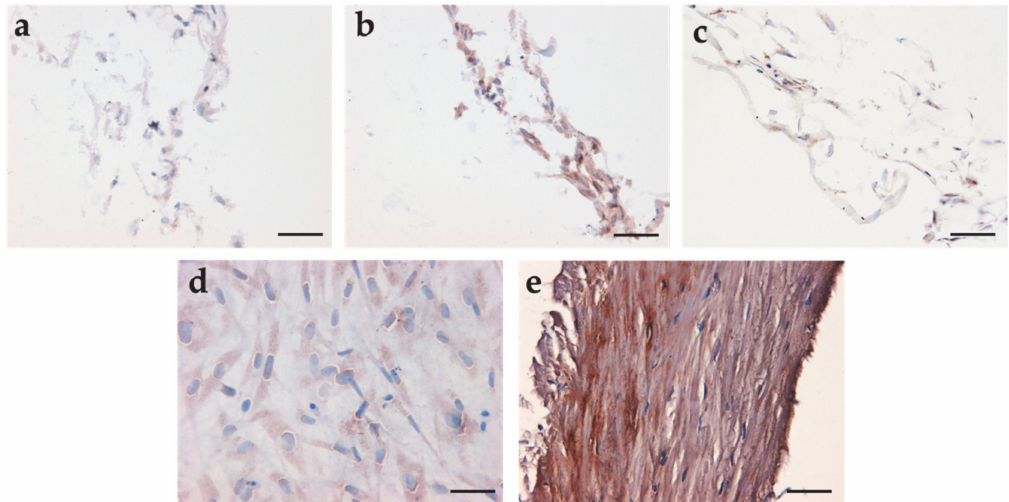
Figure 5. Immunohistochemical analysis of hMSC / *PCL constructs showing collagen type II expression inbrownandcellnucleiinvioletasobtainedviaimmunohistochemistryon: ( a – c )hMSC / *PCLconstructs: ( a ) statically di ff erentiated, ( b ) dynamically di ff erentiated, ( c ) undi ff erentiated; ( d ) undi ff erentiated hMSCs cultured on chamber slides; ( e ) human TMs. ( a – e ) Scale bar is 50 µ m. Original magnification 400 × .